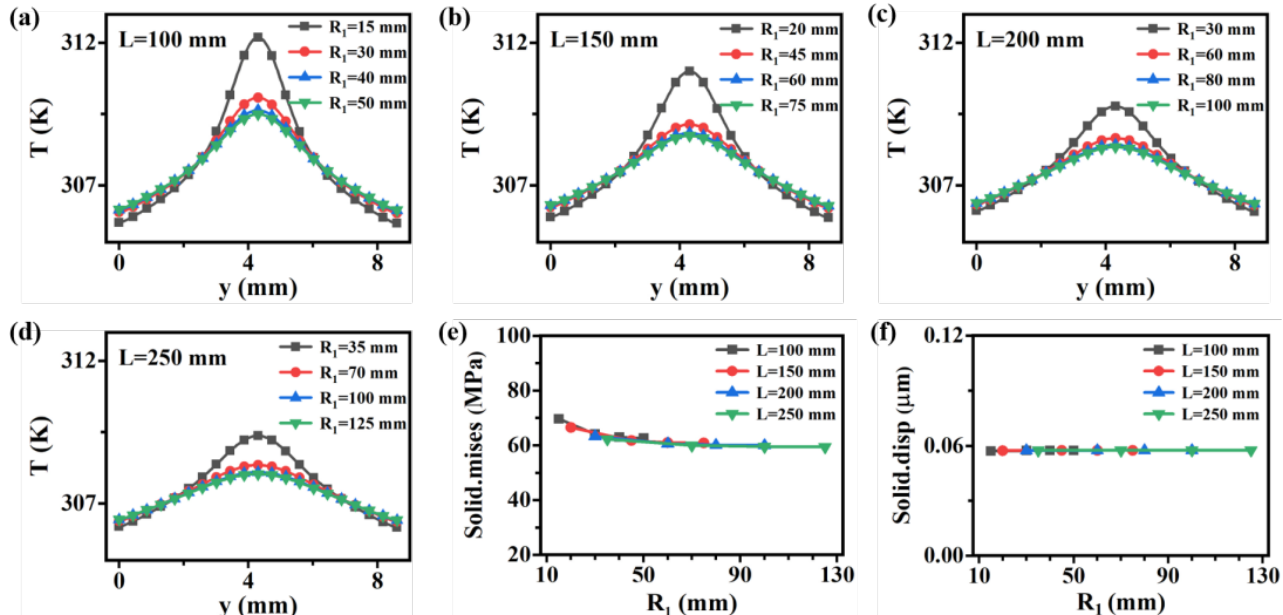
Figure 7. Cross-sectional temperature distribution of diamond crystal with concentric cavity of different radii of curvature at different cavity lengths, ( a ) 100 mm, ( b ) 150 mm, ( c ) 200 mm, and ( d ) 250 mm. Distribution of ( e ) maximum thermal stress, and ( f ) maximum thermal deformation inside crystals with a symmetrical concentric cavity at different radii of curvature.